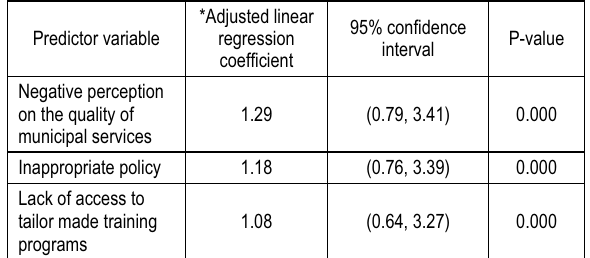
Table 4. Adjusted linear regression